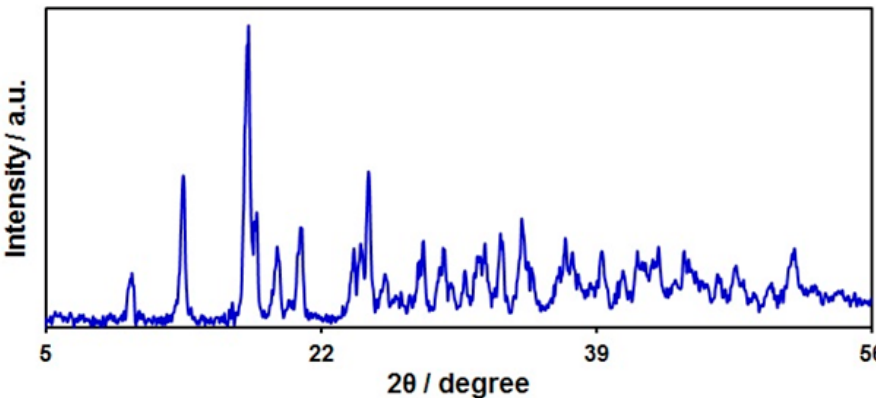
Figure 2. EDX spectrum of sheaf-like Ce-BTC MOF.